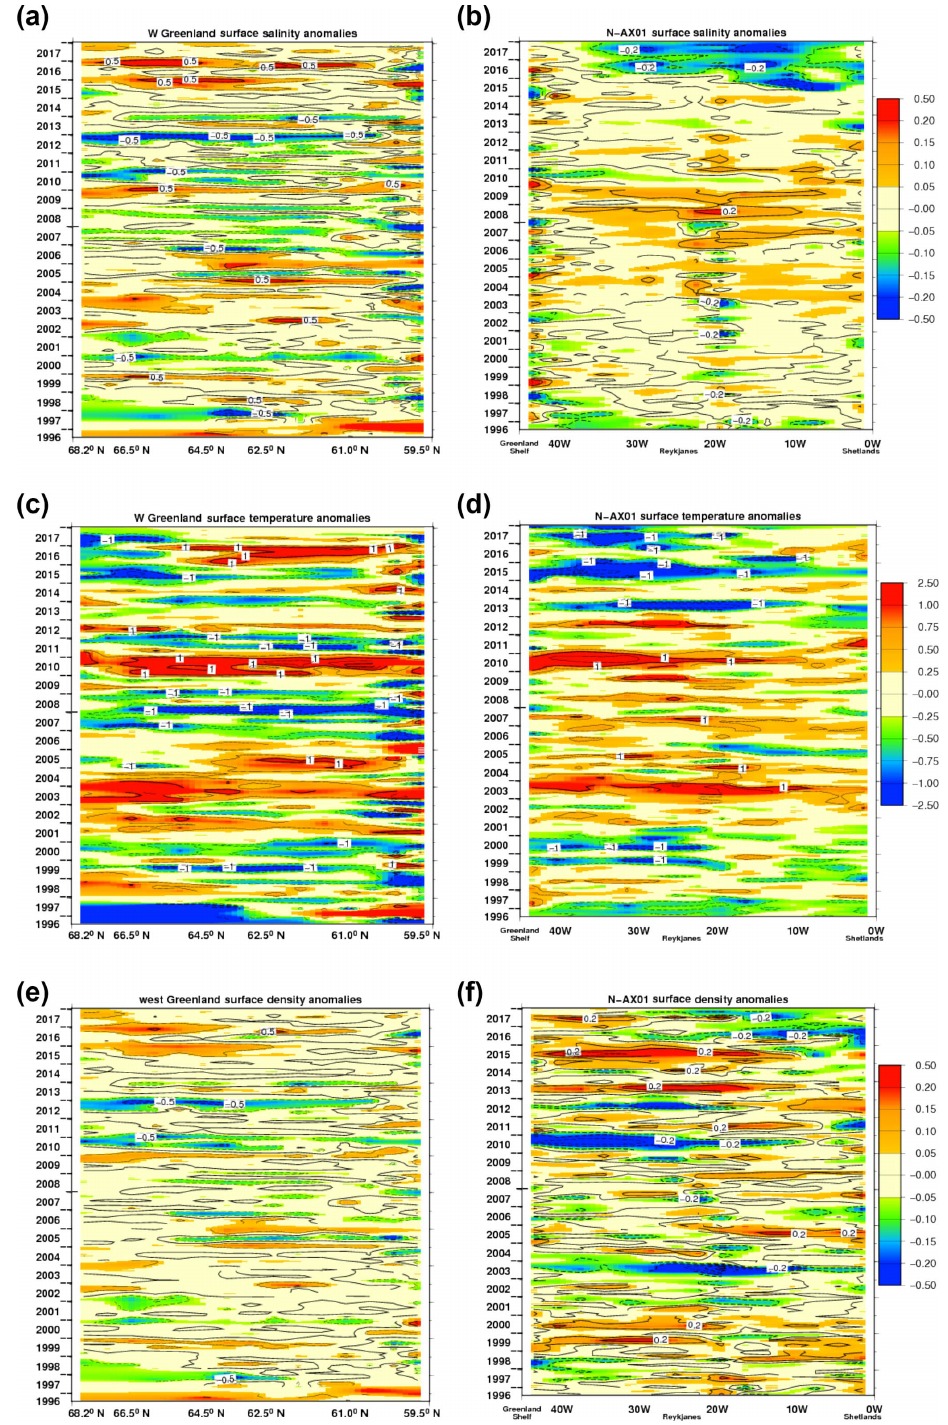
Figure 3. G-AX01 (a, c, e) and N-AXO1 (b, d, f) anomalies Hoevmøller diagrams of deviations from an average seasonal cycle. Salin- ity (a, b) , temperature ( c, d , ◦ C), and density ( e, f , kgm − 3 ) (see Fig. 1 for locations of sections). For salinity and density, different con- tours/color codes are used for G-AX01 and